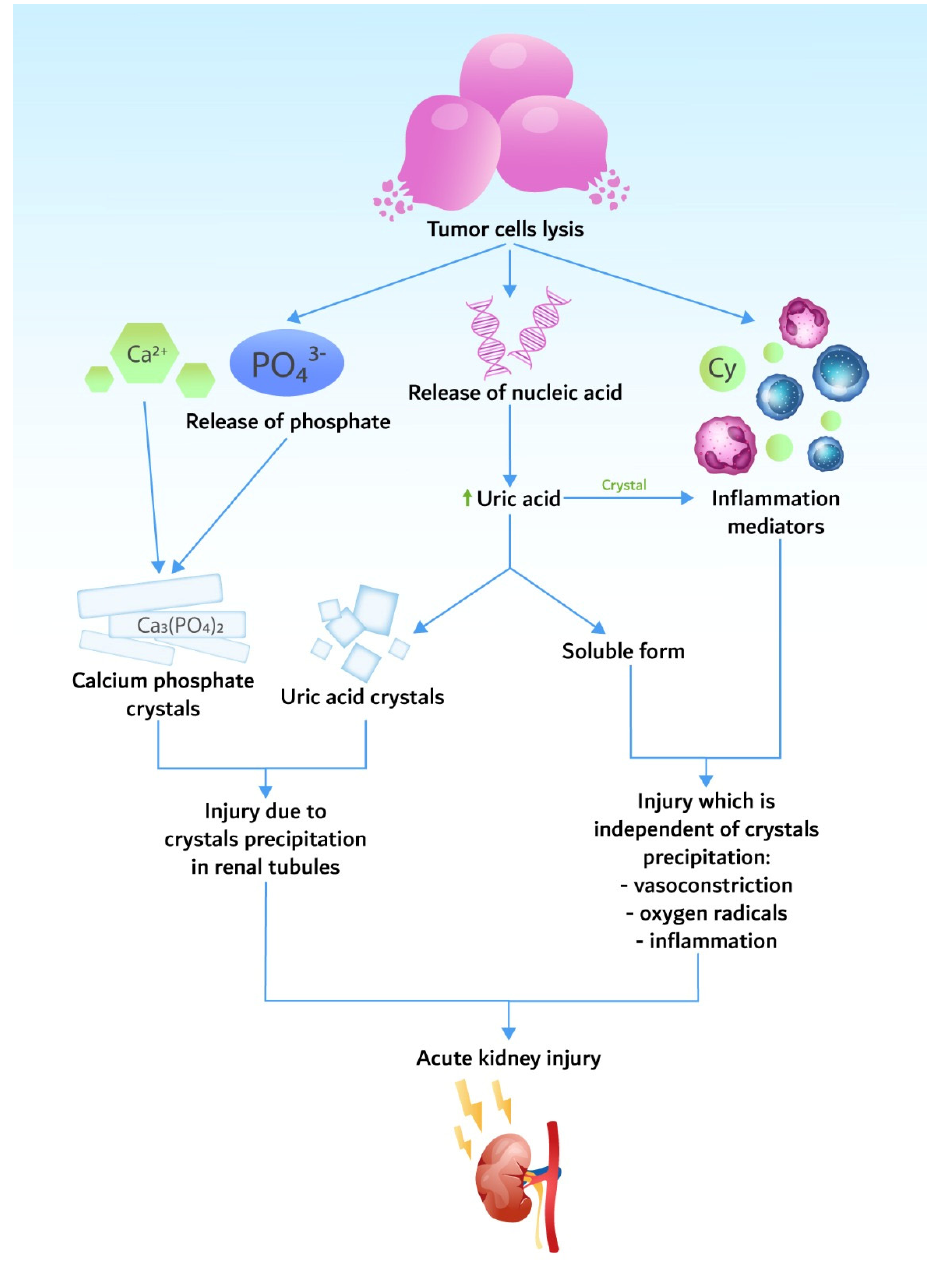
Figure 1. Pathogenesis of tumor lysis syndrome, resulting in acute kidney injury.